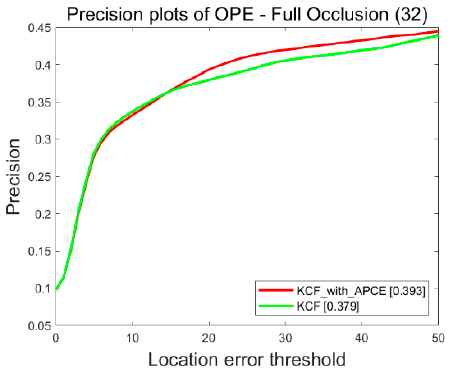
Figure 5. Experimental results of adaptive learning rate.